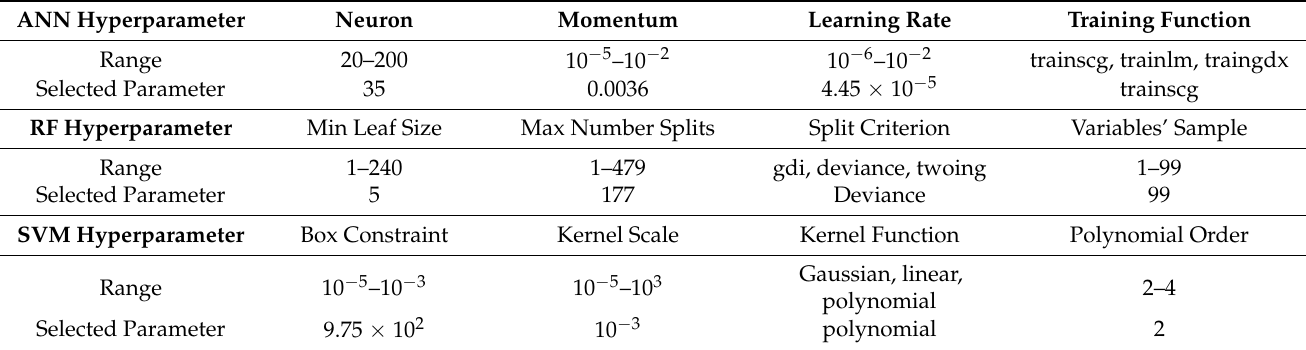
Table 1. The classification model’s optimized hyperparameter and their ranges by the Bayesian optimization method.